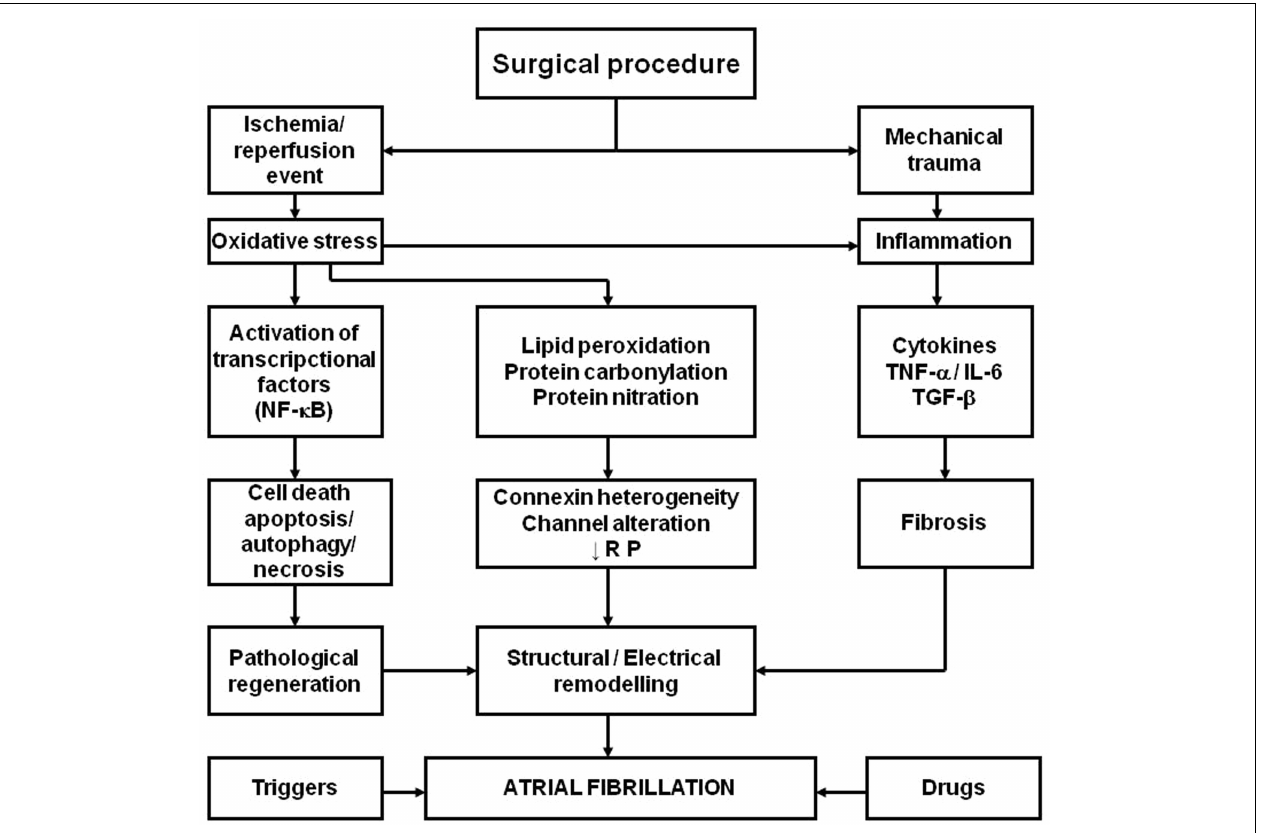
circulation. NF- κ B, nuclear factor kappaB;TNF- α , tumor necrosis factor- α ; IL-6, interleukin-6;TGF- β , transforming growth factor- β ; RP, refractory period. Adapted from Rodrigo et al. (2008) with